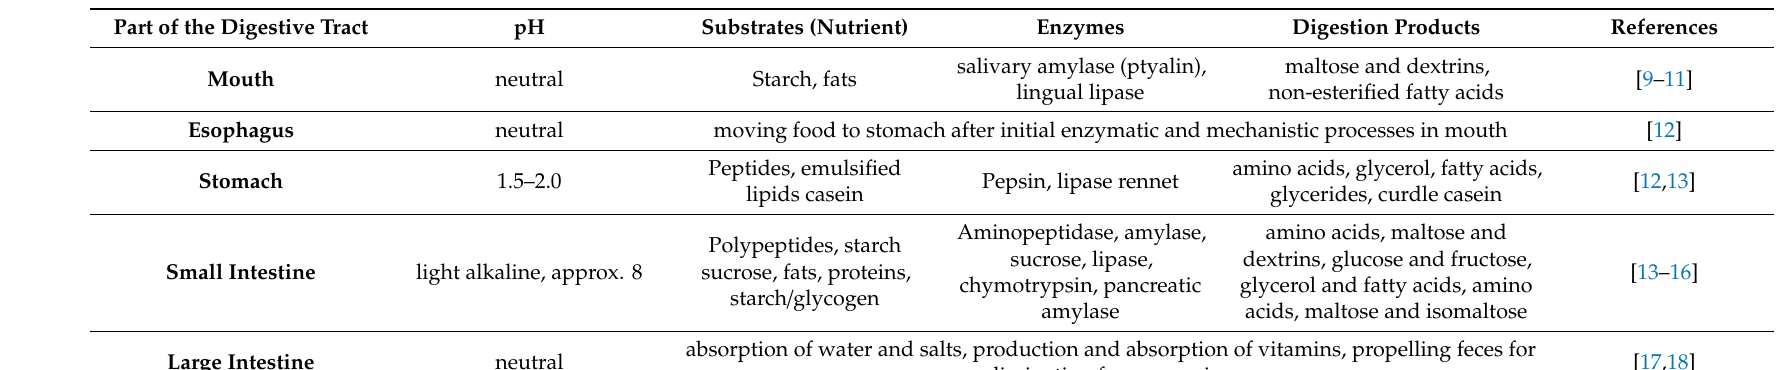
Table 1. Analysis of processes in the digestive